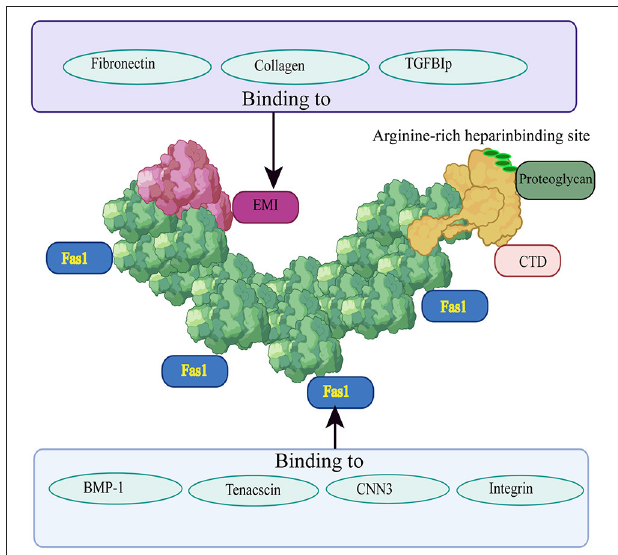
FIGURE 1 | Structure of POSTN and its interactions with other ECM proteins. The EMI domain is depicted in red, the four-repeat FAS1 domain is shown in green, and the CTD is highlighted in yellow. Fibronectin, collagen II, and TGFB1 can bind to the EMI domain; the four repeated FAS1 domains can interact with BMP-1, tenascin C, CCN3, and integrin; the CTD includes an arginine-rich heparin binding site which is responsible for binding to proteoglycans. Different regions bind to different proteins and play different